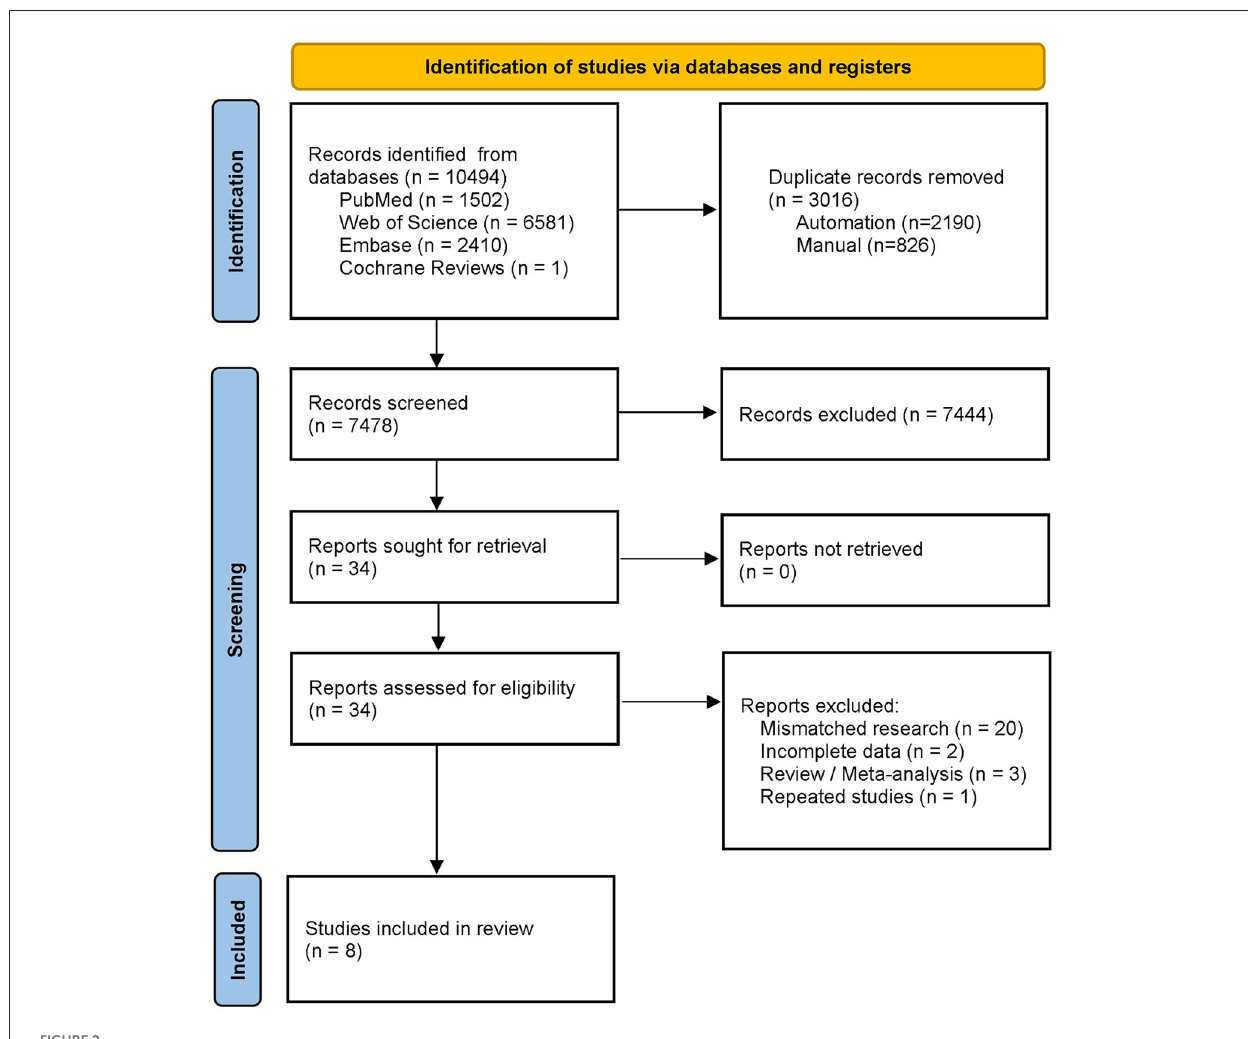
FIGURE2 PRISMA flow diagram for study selection.